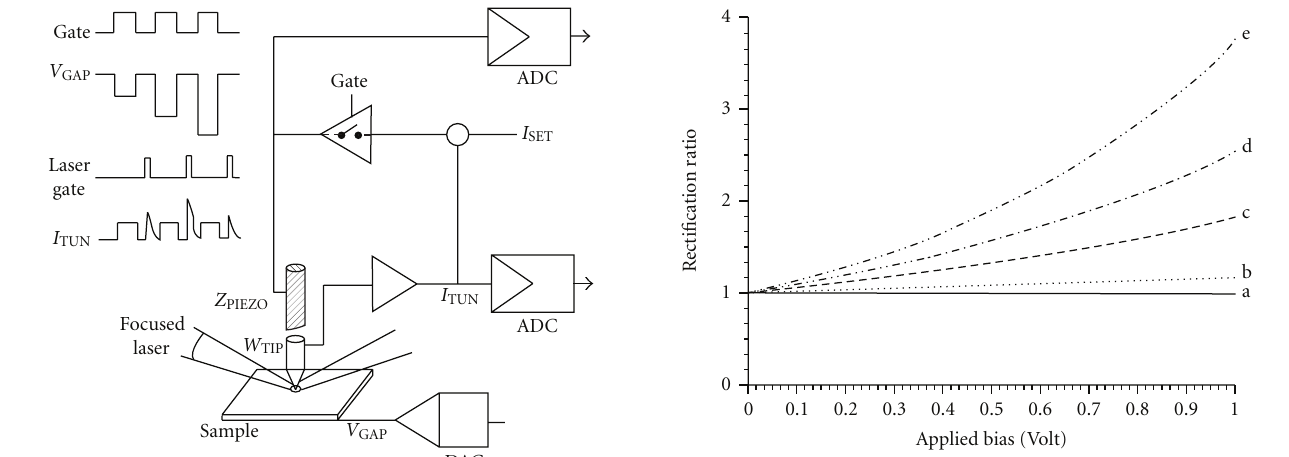
Figure 9: Schematic of laser irradiated STM junction rectification experiment from [12].